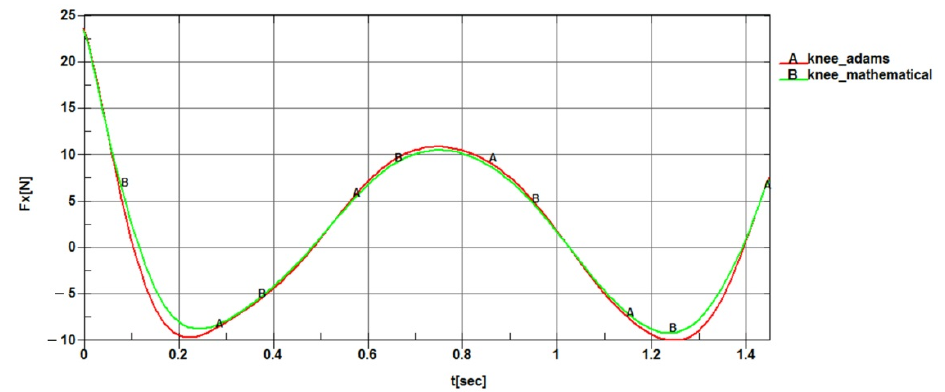
Figure 11. Connection forces component on x-axis for knee joint vs. time (without ground contact).